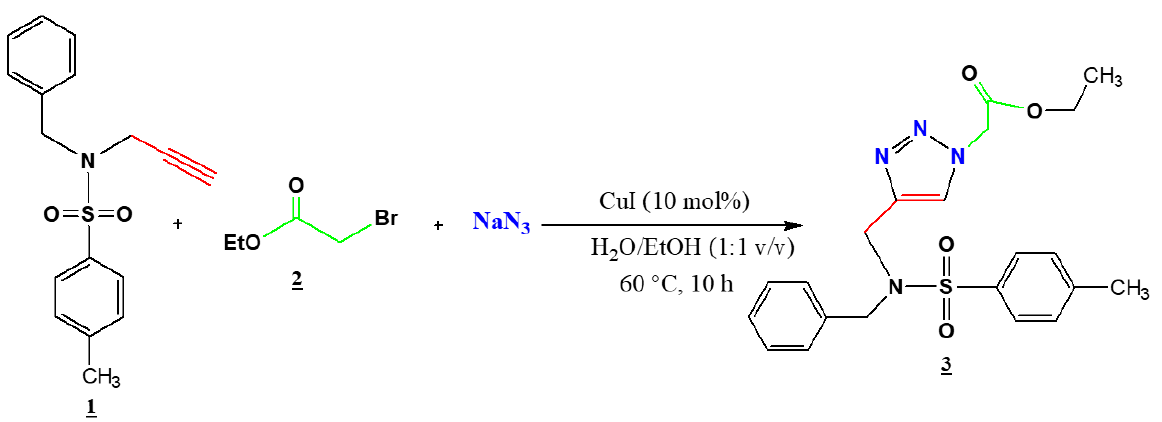
Figure 3. An effective synthetic strategy for the synthesis of new 1-ester-4-sulfonamide-1,2,3-triazole scaffolds by click reaction.